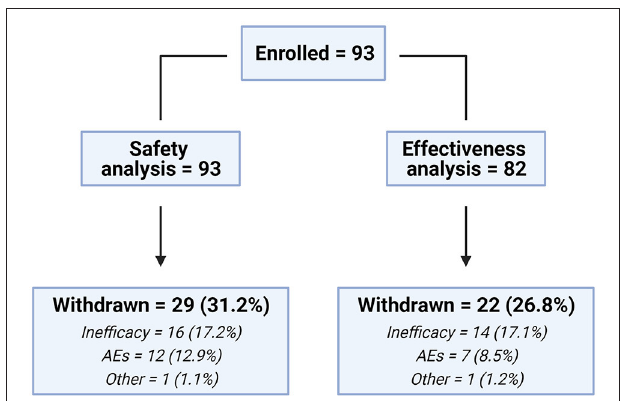
FIGURE 1 | Patients’ distribution flowchart. AEs, adverse events. Created with Biorender.com.